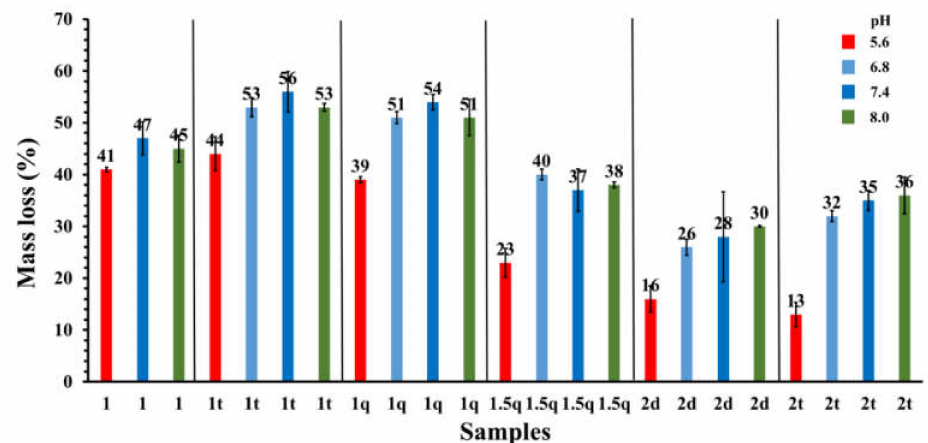
Figure 4. Mass loss of the hydrogel samples in media of different pH, over 9